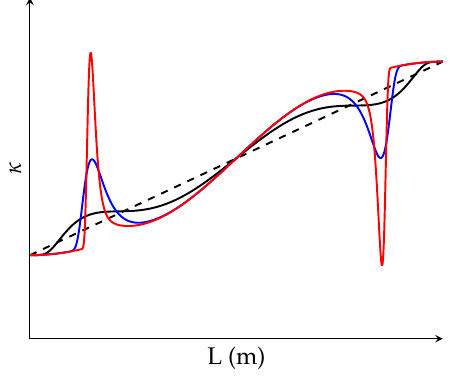
Figure 19. Curvature plots of the clothoid (dashed) and blending splines in [ p 1 , q 1 ] for tightening parameters α , γ = 1,1 (black, default), α , γ = 4,1 (blue), and α , γ = 10,1 (red).